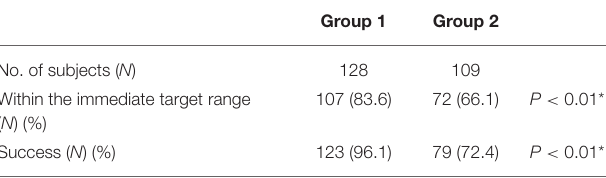
TABLE 4 | Primary and secondary outcomes in each group.